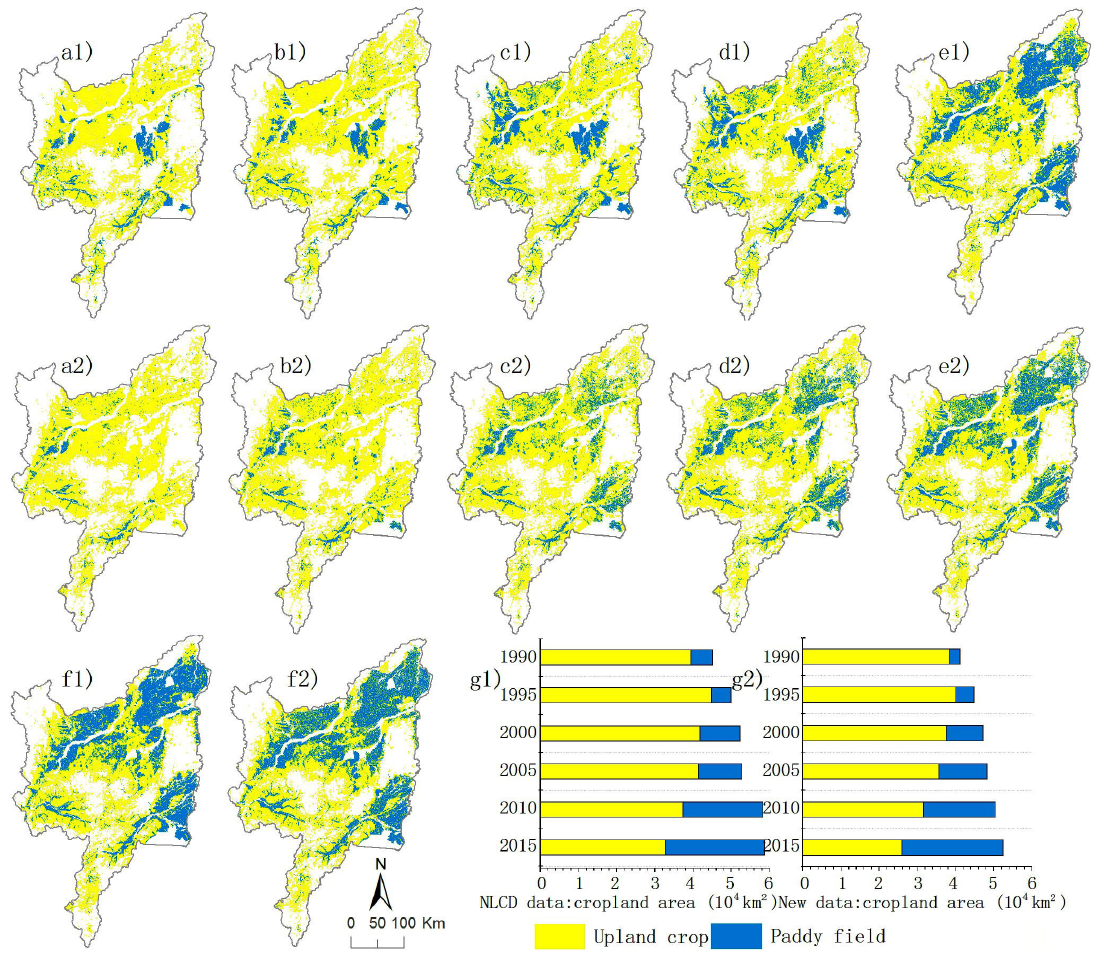
Figure 6. Resulting maps of cropping patterns and statistics for the NLCD-based and new-based datasets of the Sanjiang Plain in the six epochs from 1990 to 2015. Cropping patterns: NLCD-based dataset: ( a1 ): 1990; ( b1 ): 1995; ( c1 ): 2000; ( d1 ): 2005; ( e1 ): 2010; and ( f1 ): 2015; new-based dataset: ( a2 ):